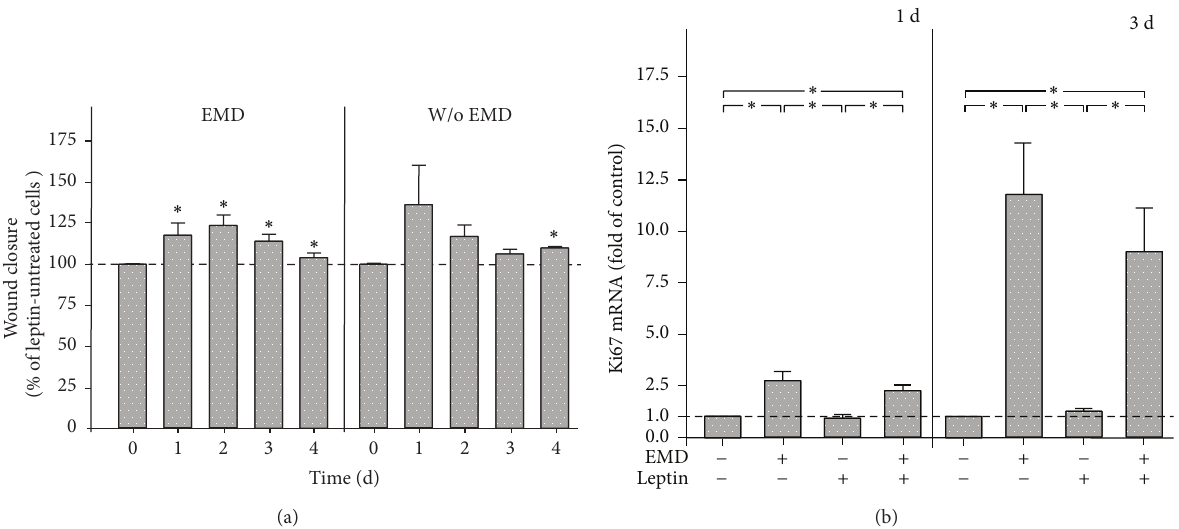
Figure 2: Effect of leptin (3 ng/mL) on wound closure in the presence and absence of EMD (a). The wound closure, that is, the percentage of fill of the initially cell free zones created by wounding, was analyzed over 4d. Mean ± SEM ( 𝑛 = 12 ); ∗ significantly ( 𝑃 < 0.05 ) different from leptin-untreated cells. Effect of EMD and/or leptin (3ng/mL) on Ki67 mRNA at 1d and 3 d (b). Untreated cells served as control. Mean ± SEM ( 𝑛 = 18 ); ∗ significant ( 𝑃 < 0.05 ) difference between